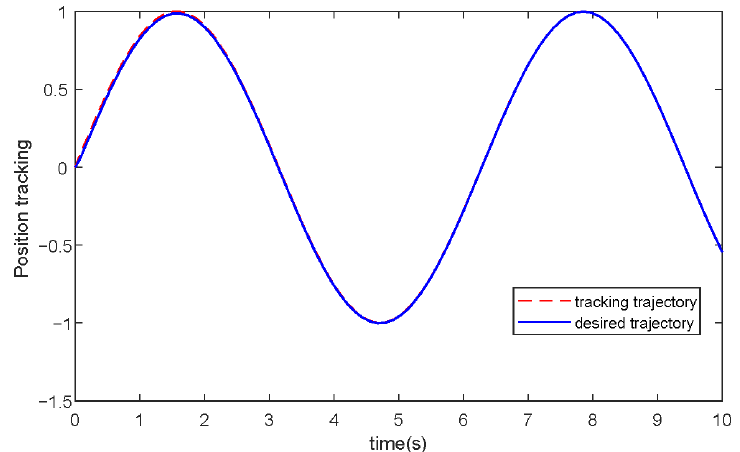
Figure 7. Position tracking curves under the first case.